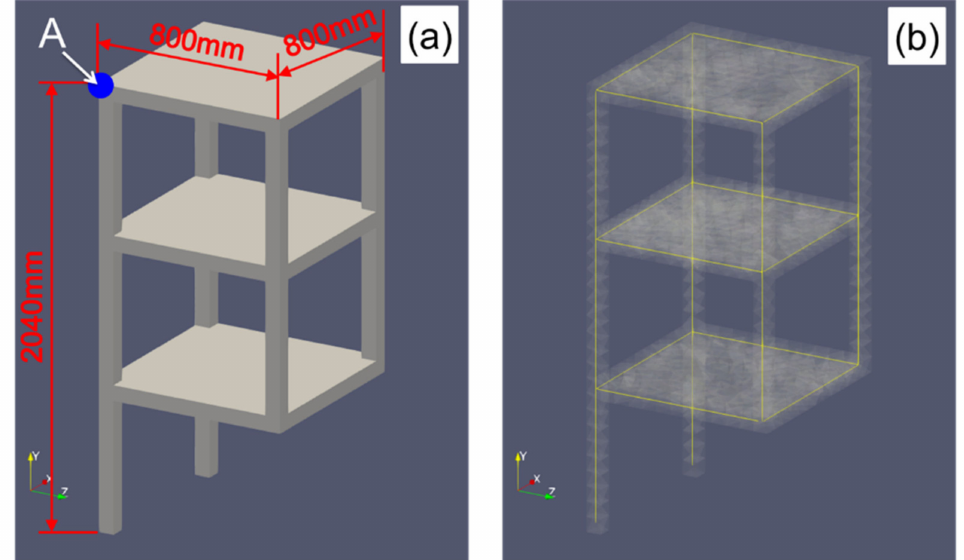
Figure 14. A numerical model for simulating the demolition of a small-scale RC structure: